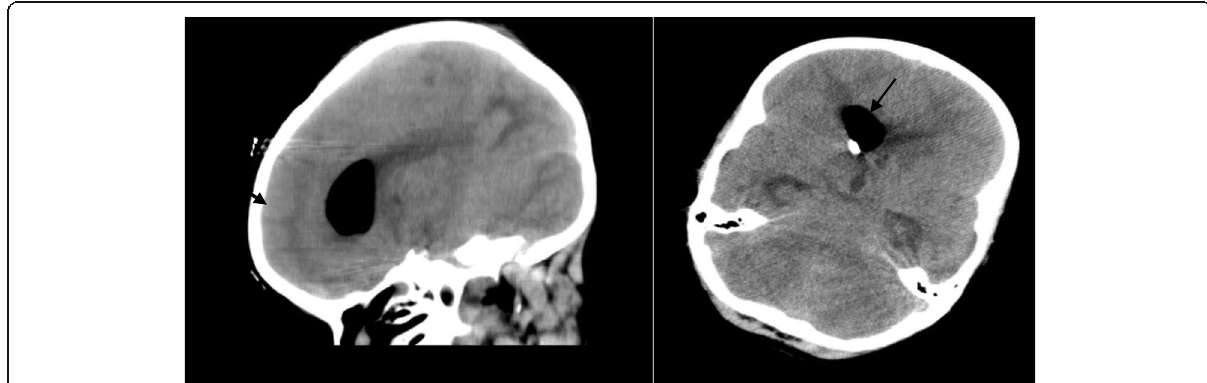
Fig. 1 CT images of a 4-year-old patient who underwent Fontan surgery in single ventricular physiology after postoperative bleeding in the left temporal lobe (indicated by the black arrow). Extensive intracranial bleeding developed in the patient ’ s left temporal region on the fourth